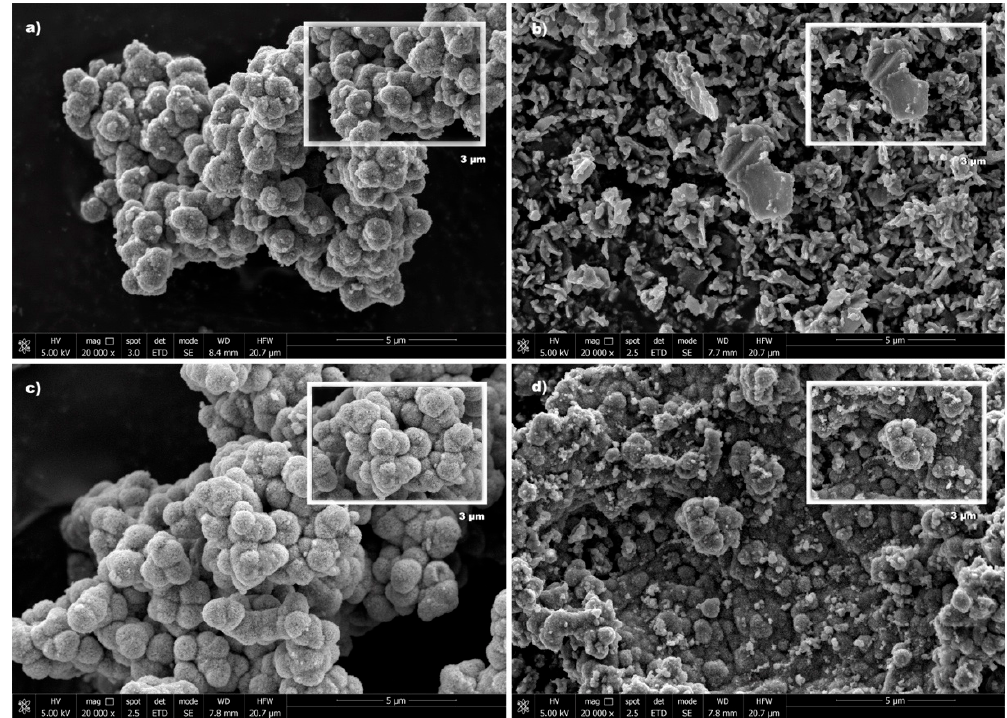
Figure 3. SEM micrographs of ( a ) TiO 2 , ( b ) GO-T, ( c ) rGONS-T, and ( d ) rGOB-T.